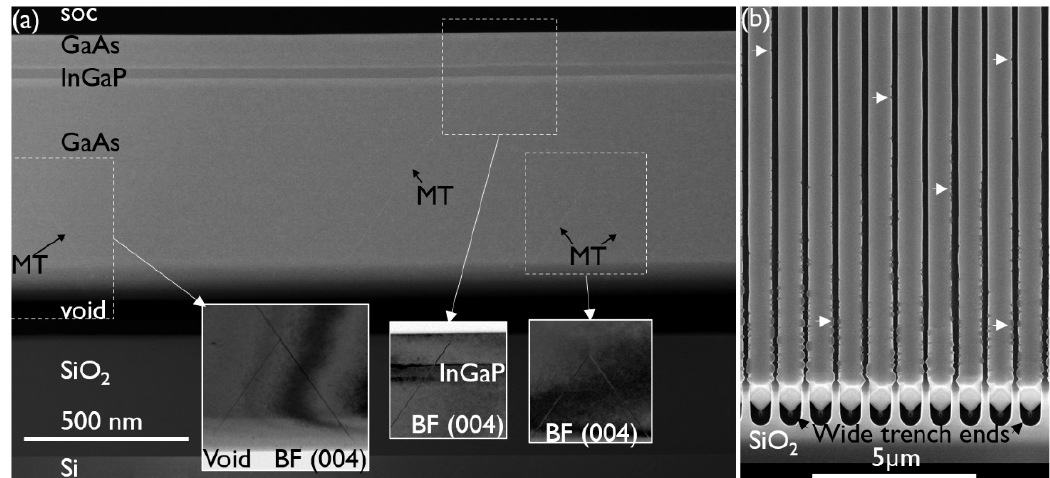
Figure 2. Cross-section (stitched) TEM images of a HBT layer stack viewed under ( a ) two-beam BF (220) and ( b ) HAADF-STEM conditions with all device layers indicated. The broad arrow points to the approximate off-center location for the longitudinal cut shown in Figure 3.